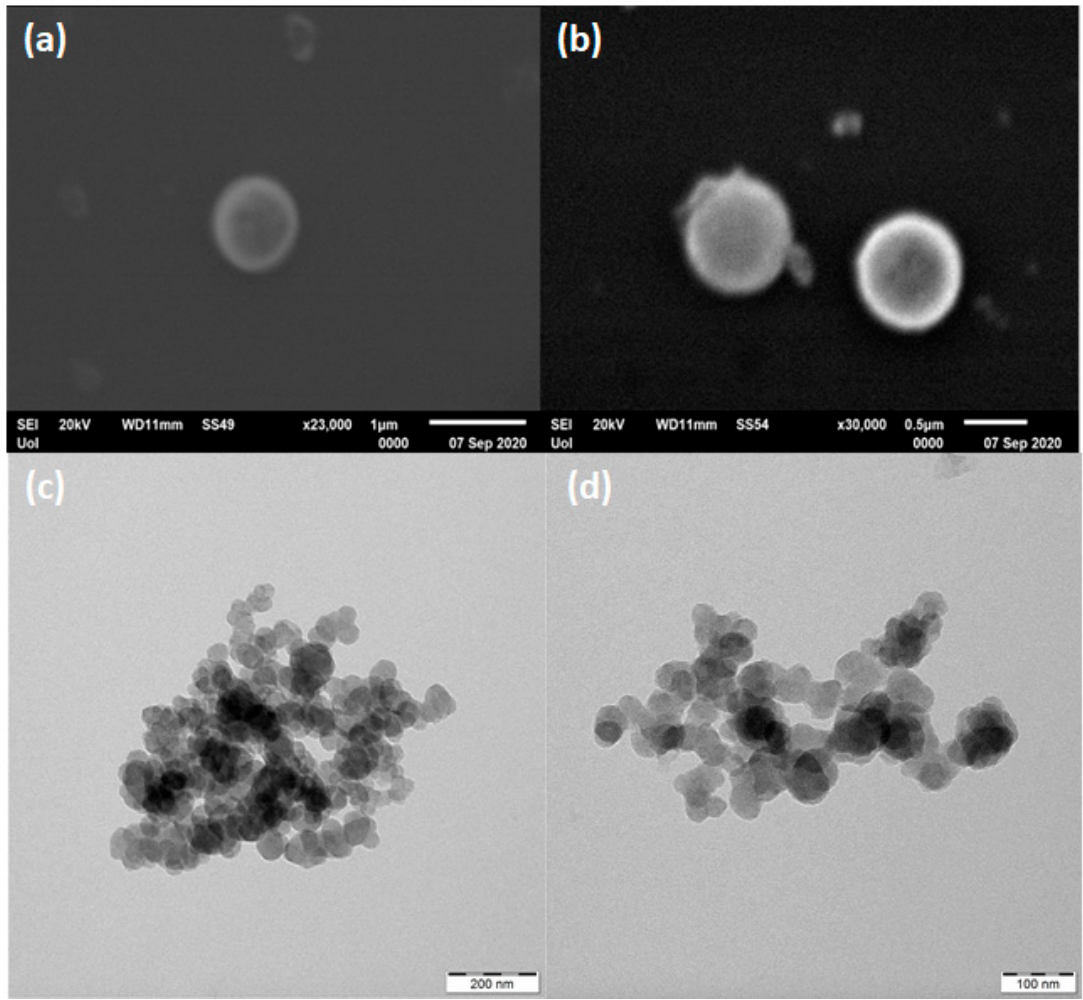
Figure 7. SEM ( a , b ) and TEM ( c , d ) images of carbon discs.